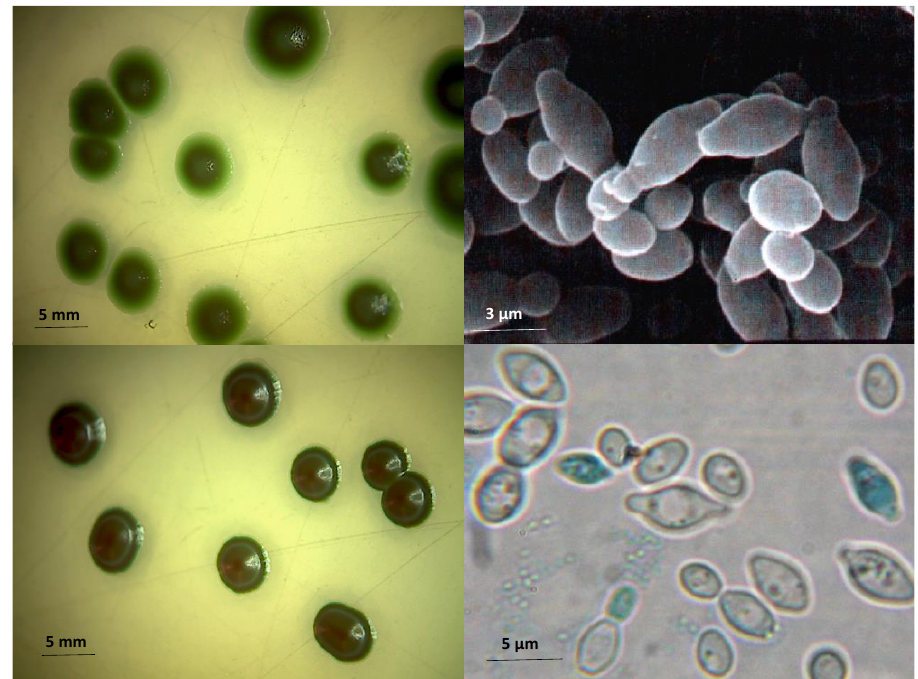
Figure 1. On the left-hand side are the typical colony color and morphology for Hanseniaspora/Kloeckera strains that are readily differentiated from other yeast genera in WL nutrient agar medium. However, is more difficult to distinguish between species, although some slight differences between H. uvarum ( upper ) colonies and H. vineae ( lower ) colonies can be appreciated in these photos. On the right-hand side, H. uvarum is visualized by electron microscopy and H. vineae is visualized with blue methylene stain.